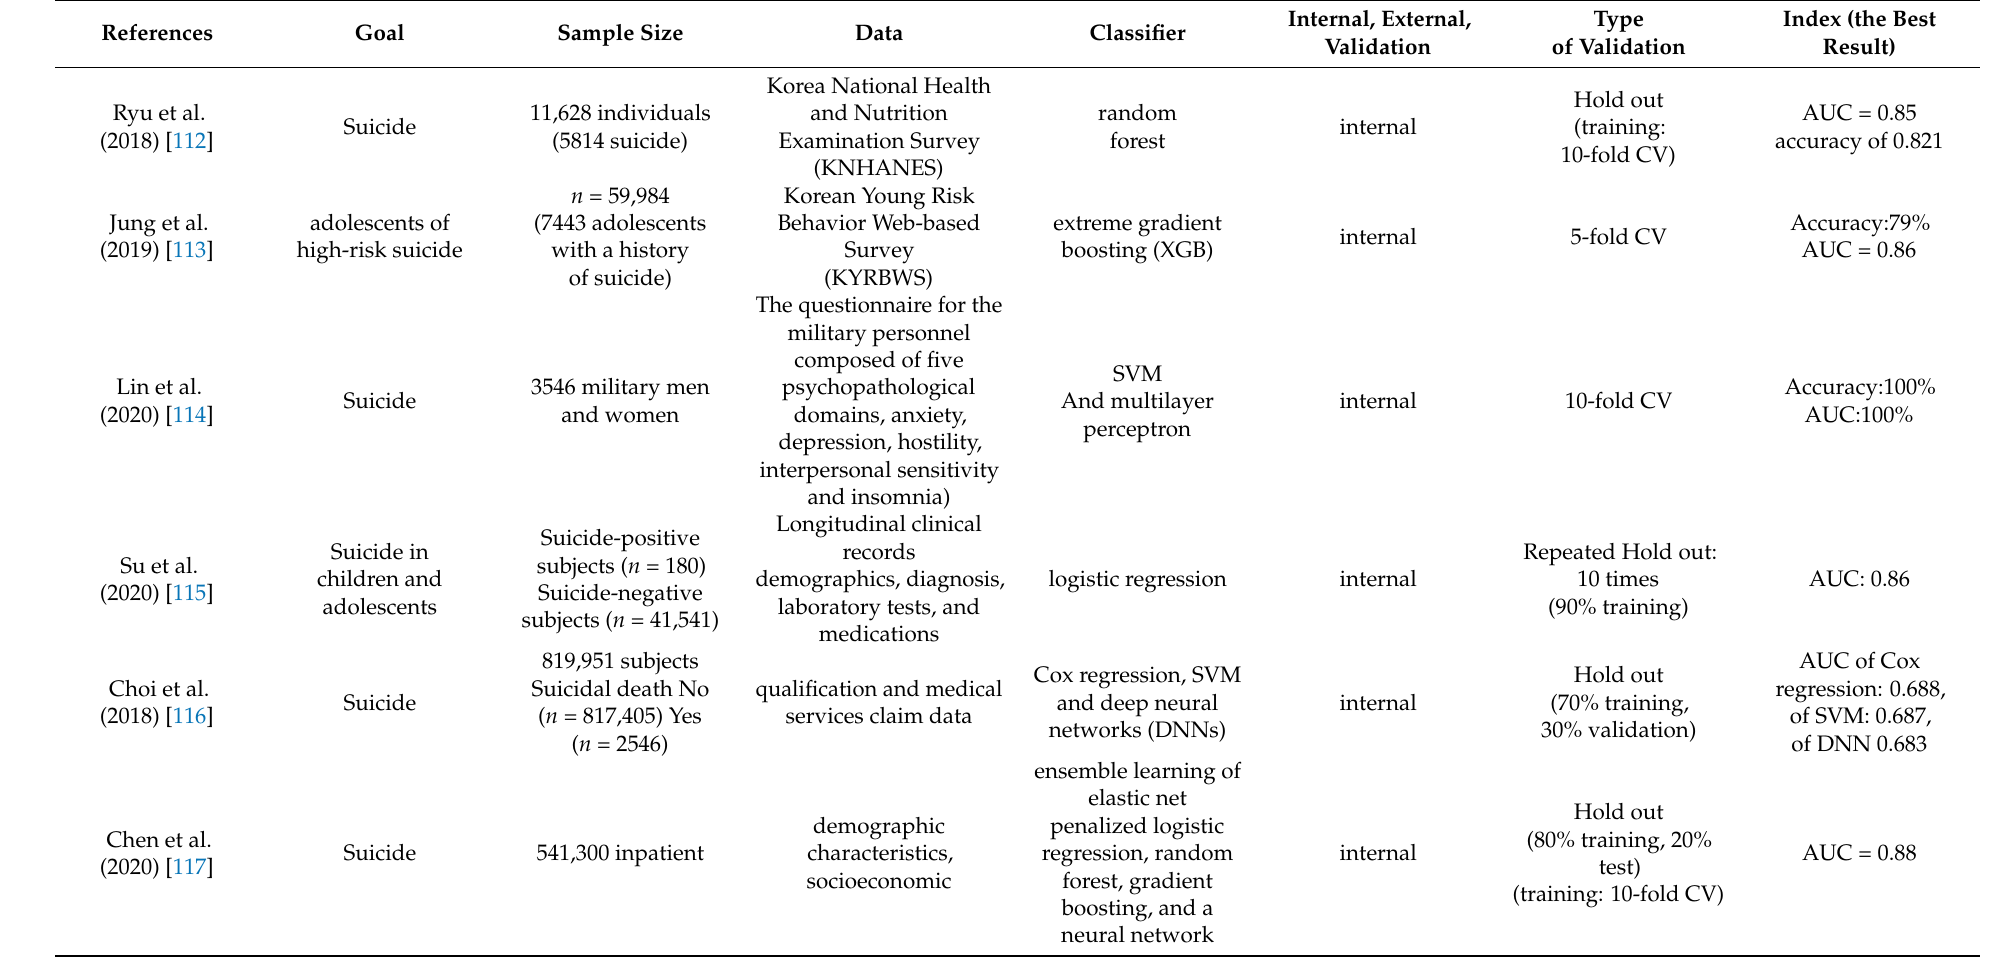
Table 9. CAD methods for suicide prediction